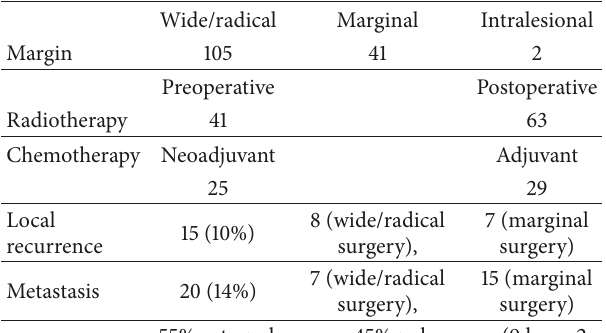
Table 2: Surgical margins, radiotherapy, chemotherapy, local recur- rence, and